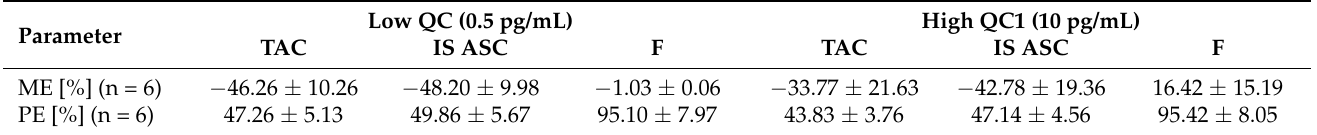
Table 3. Summary of the matrix effect and process